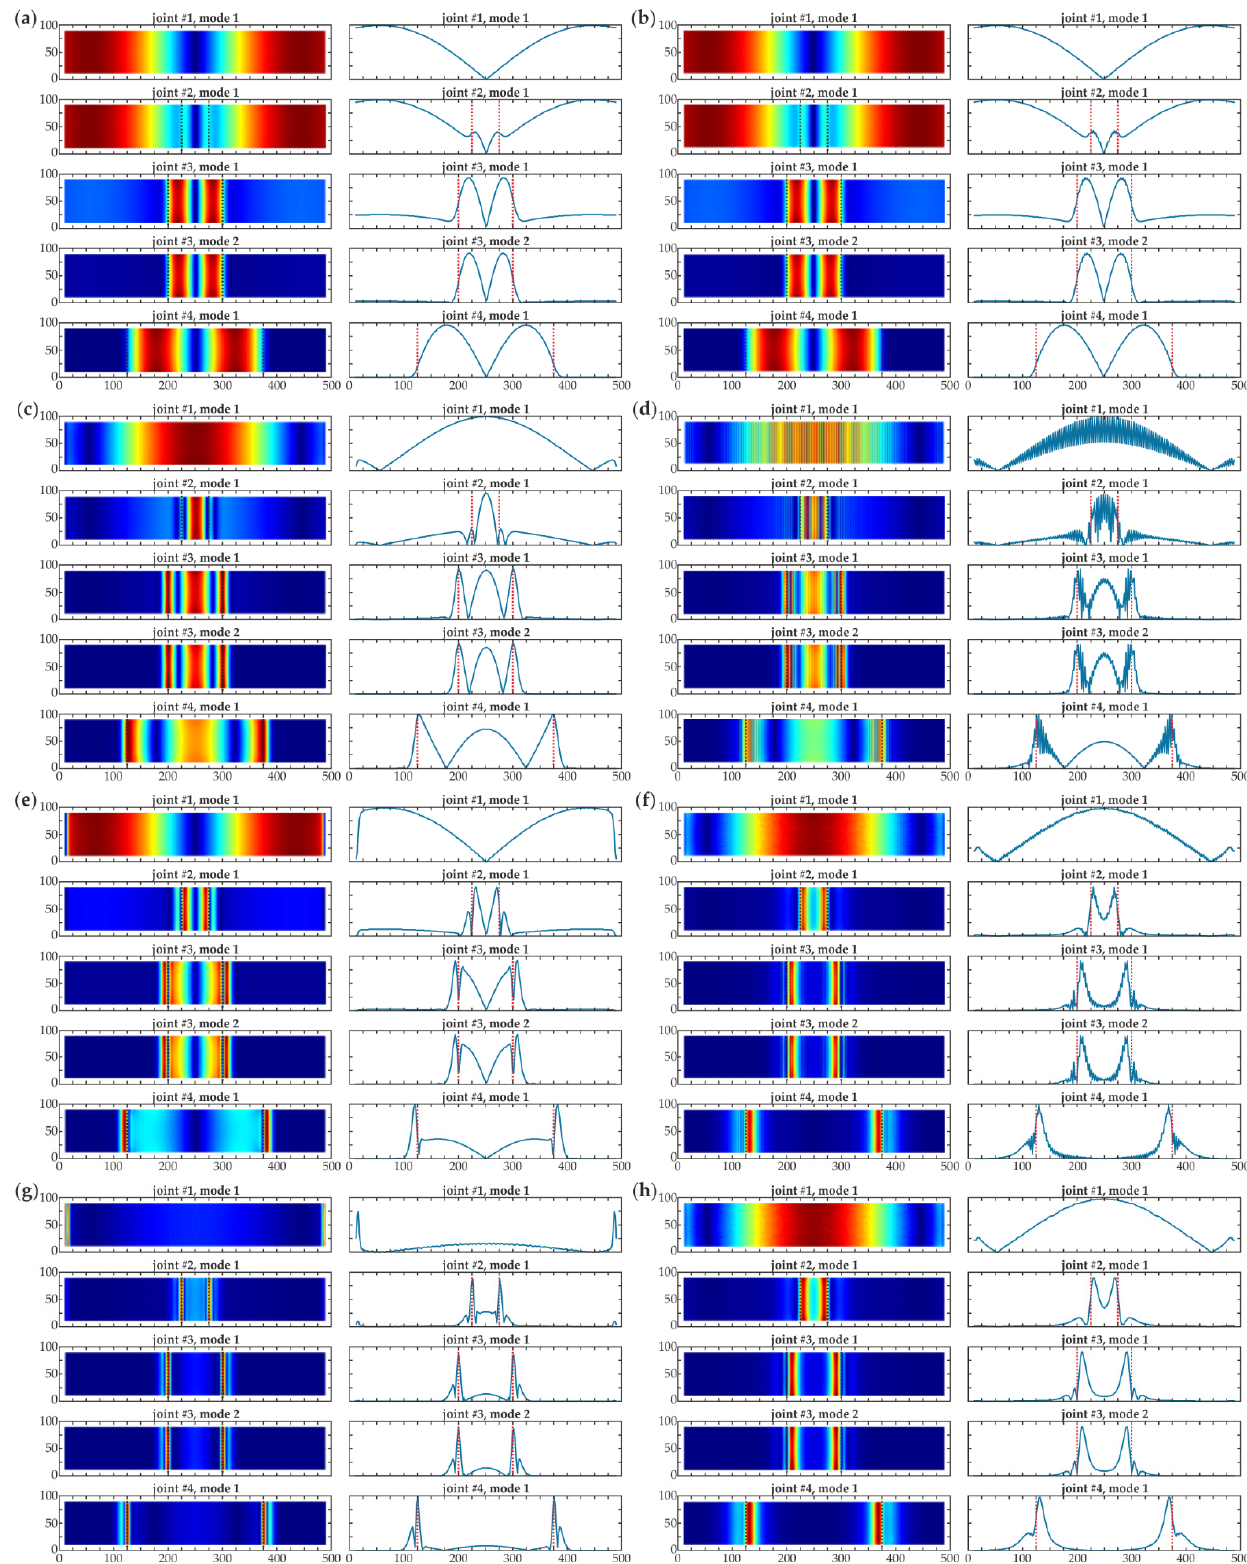
Figure 6. Damage imaging for numerical results (mesh 2 mm, no additional interpolation) for all joints #1–#4 (dimensions in [mm]) — map and central cross section: ( a ) CWT, wavelet gaus1 , s = 2; ( b ) first derivative; ( c ) CWT, wavelet gaus2 , s = 2; ( d ) second derivative; ( e ) CWT, wavelet gaus3 , s = 2; ( f ) third derivative; ( g ) CWT, wavelet gaus4 , s = 2; ( h ) fourth derivative.